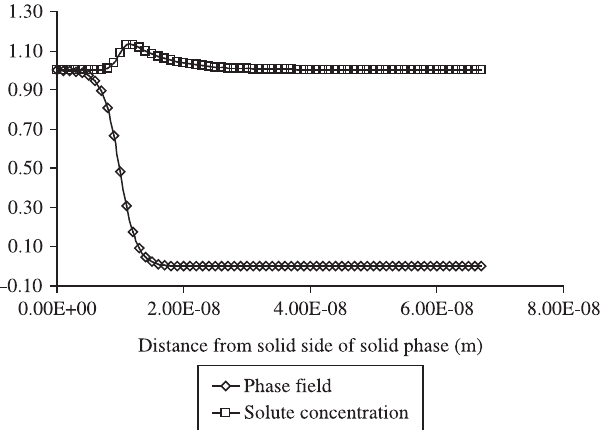
Figure 2. Dimensionless steady state Cu concentration (ratio between actual concentration and solute concentration in solid at solid side of interface) and phase field profile along the y direction determined in the present work using the phase field model of Kim et al. 6 : solidification velocity = 0.17 m/s.